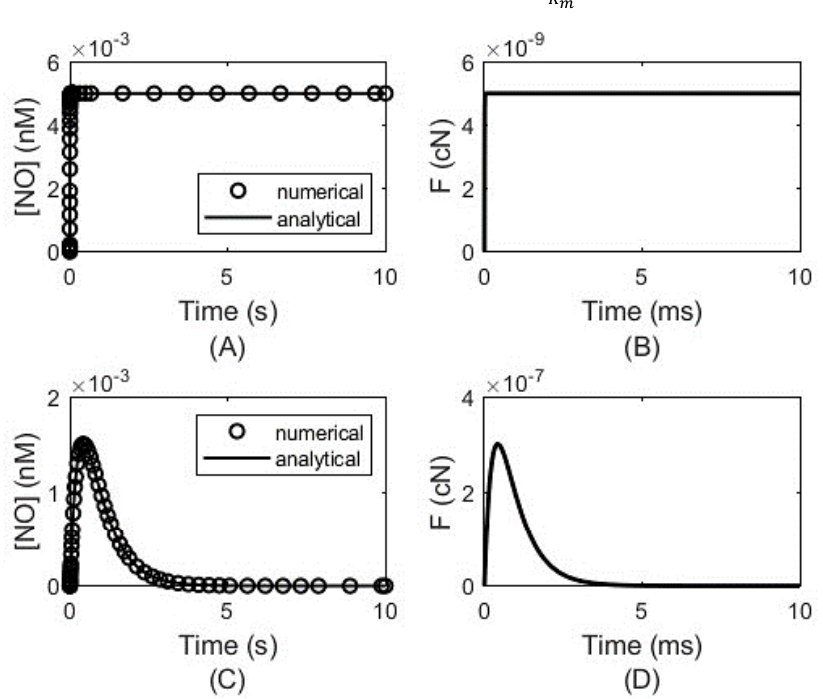
Figure 5. Profiles of [𝑵𝑶] (A, C) and magnitudes of force 𝑭 (B, D) proportional to [𝑵𝑶] . Formulas (37) (A) and (39) (B) correspond to the case of non-decaying synthesis of and inactivation of NO. Formulas (38) (C) and (40) (D) correspond to the case of dynamic synthesis and inactivation of NO. Numerical solutions to differential equations (35) (A) and (36) (C) are also